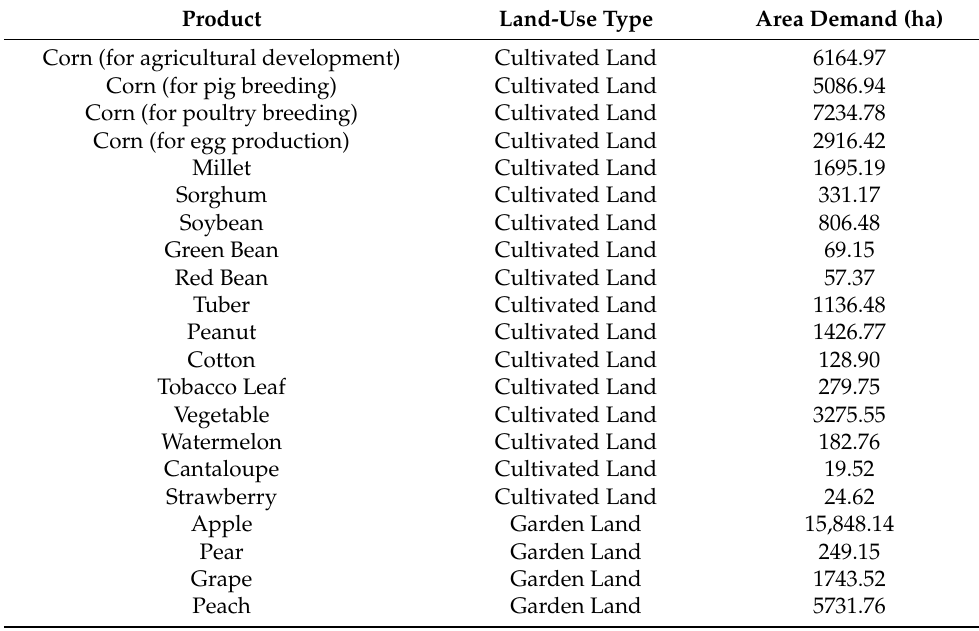
Table 6. Area demand for primary industry products to realize GDP.